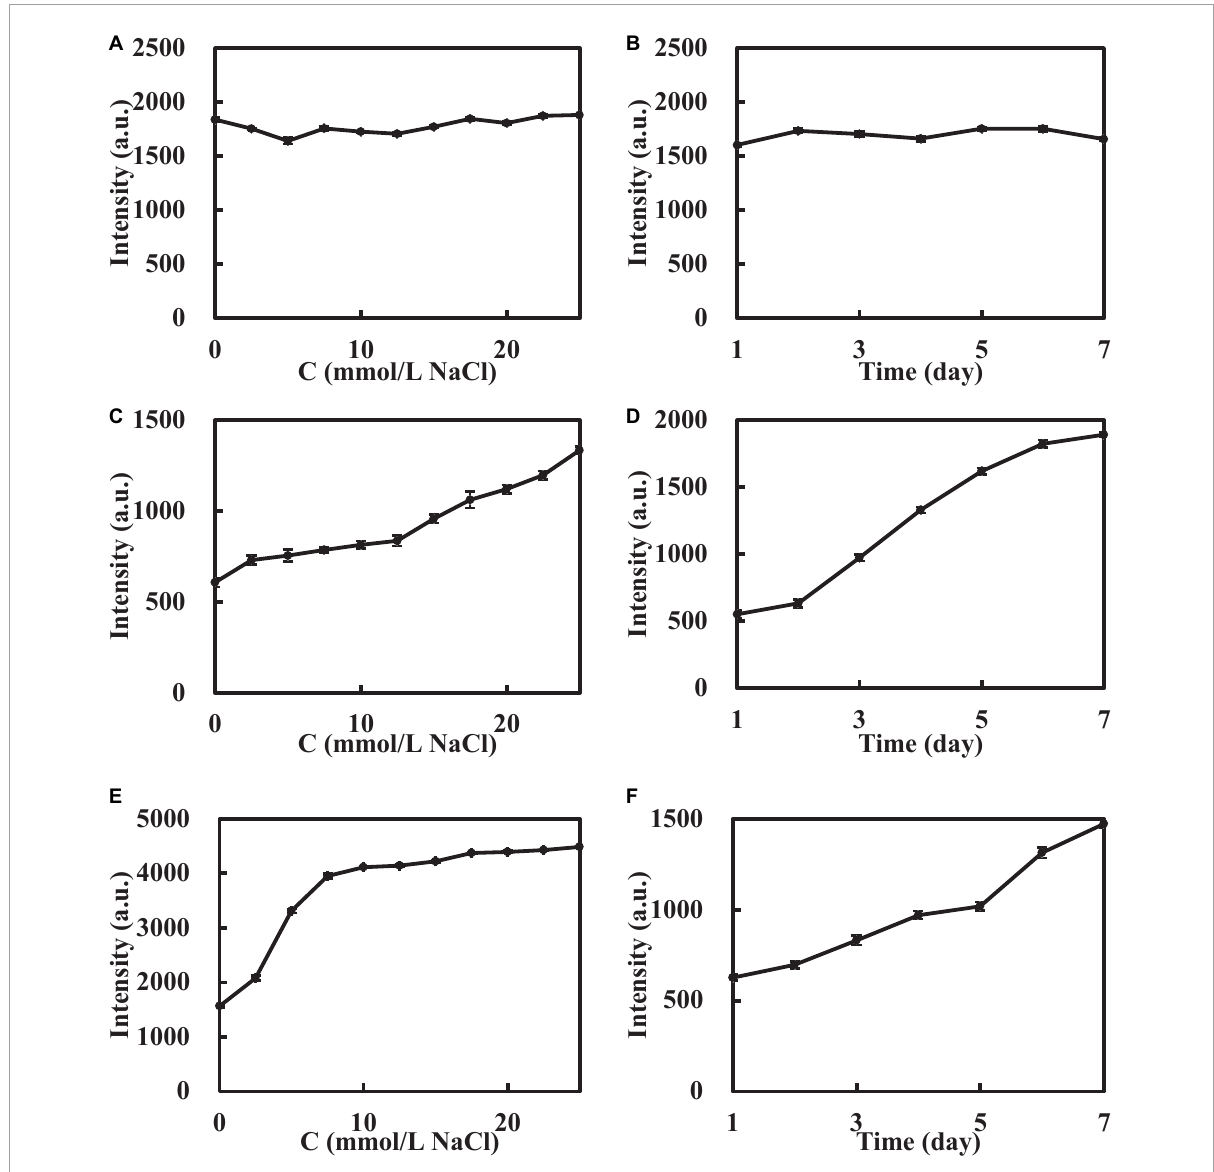
FIGURE4 Stability of the nanosol. (A) Effect of NaCl on I 330 nm of AuMOF. (B) Effect of time on I 330 nm of AuMOF. (C) Effect of NaCl on I 370 nm of AuNP. (D) Effect of time on I 370 nm of AuNP. (E) Effect of NaCl on I 370 nm of AgNP. (F) Effect of time on I 370 nm of AgNP. The concentrations of AuMOF, AuNPs, and AgNPs were 20.0 µ g/mL, 21.6 µ mol/L, and 13.5 µ mol/L